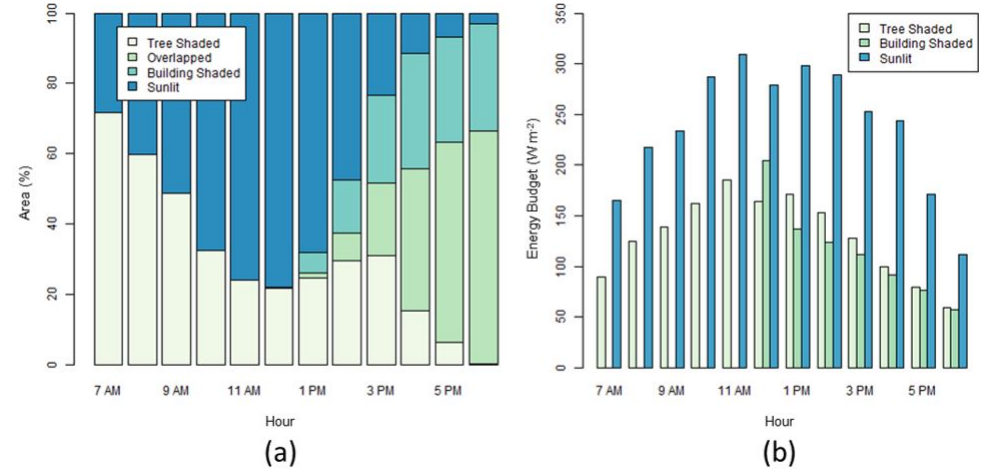
Figure 8. ( a ) Sunlit, building- and tree-shaded area fraction on street; ( b ) average EB for sunlit, building- and tree-shaded area on